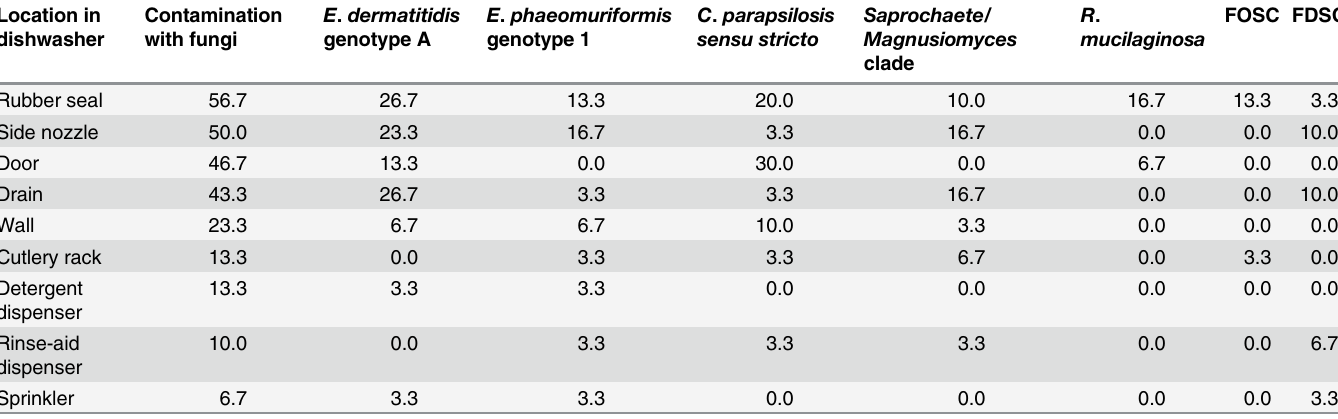
Table 3. Comparison of occurrence (%) of selected opportunistic pathogenic fungi in 9 locations of 30 residential dishwashers, sampled in the present study. Location in